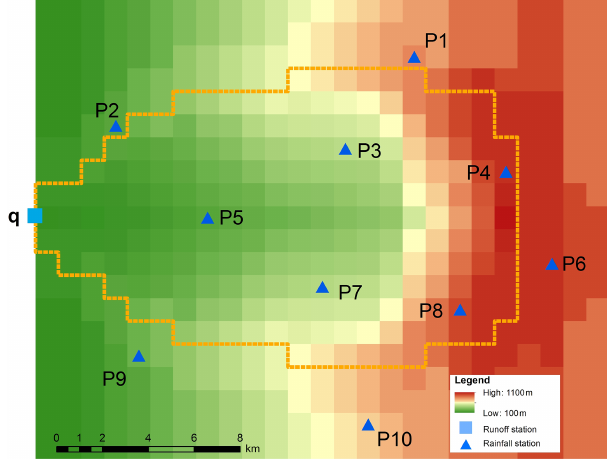
Figure 2. Topography, watershed, and observation network of the synthetic catchment.